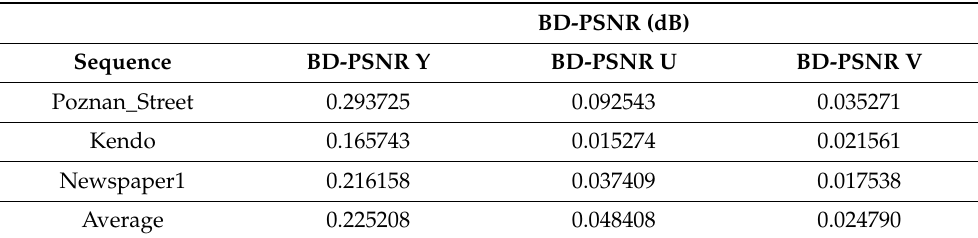
Table 2. BD-PSNR of the proposed single-layered stereo video codec with respect to the anchor MV-HEVC codec.